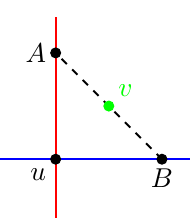
Figure 4 . The D3 brane at v denoted by the green dot is placed on the 7-7 junction AB stretched between two stacks of 7-branes intersecting at u . The 7-7 junction is represented by the dashed line and the two stacks of 7-branes are represented by the red and blue lines. The two 3-7 junctions are Av and vB with asymptotic charges a ( J ) and − a ( J ) respectively and clearly they combine into the full 7-7 junction AB .